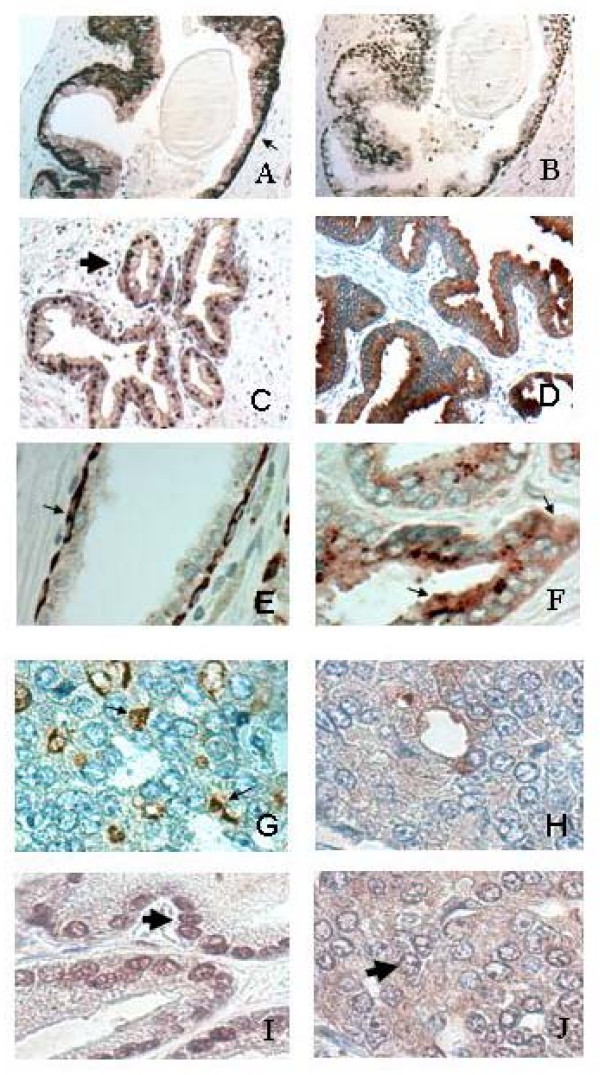
Localization of C/EBPα, p63, AR and PSA in normal and cancerous prostate epithelium. Tissue sections of human prostate glands were stained with antibodies to C/EBPα, p63, AR and PSA as detailed in the Methods. Shown are representative fields of normal and hyperplastic epithelium (panels A-E) and regions with cancer (panels F-J). Panels A, E, F, and G were stained for C/EBPα, Panels D and H were stained for PSA, Panel B was stained for p63, and Panel C, I, and J were stained for AR. Panels A-D are shown at low magnification (10x objective) and Panels E-J at high magnification (40x objective). The thin arrows indicate representative areas staining positively for C/EBPα in normal and cancerous regions. In the normal or hyperplastic epithelium C/EBPα is detected in the basal layer. In Panel D strong staining of PSA is seen at the abluminal surface of the normal prostate epithelium while in Panel H weakly stained PSA is localized diffusedly throughout the cancerous epithelium. In panel I the thick arrow indicates cells staining positively for AR. In Panel J weak staining of AR is seen in some nuclei.